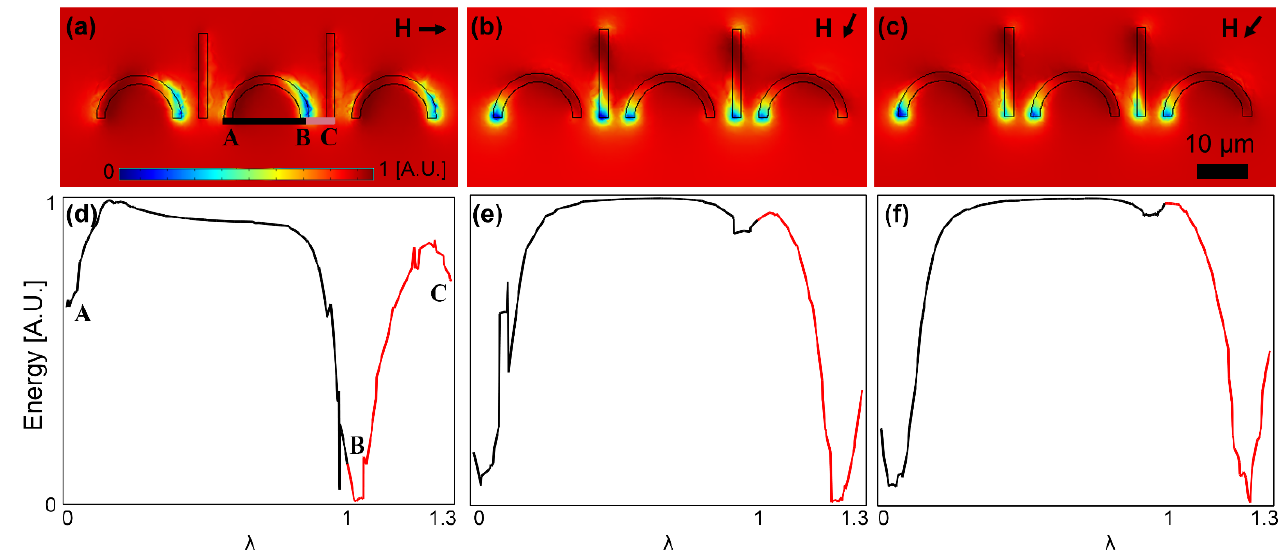
Figure 7. The particle transport failure from the I bar tip, in an unsuitable β x = 0.2, is studied. ( a – c ) The potential energy distributions for three sequential magnetic field directions are illustrated. ( d – f ) The energies along the lines AB and BC (see ( a )) for the field directions of ( a – c ) are plotted in ( d – f ), respectively. The small black arrows stand for the magnetic field directions. The field is rotating clockwise. The energies are plotted at the center of a particle with a radius of 0.5 µm. The blue and red areas indicate the regions with low and high potential energies, respectively.